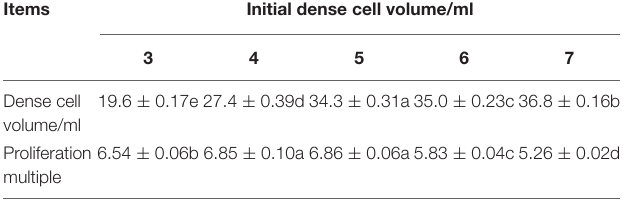
TABLE 1 | Effects of the initial density on the dense cell volume and proliferation multiple of Pinus elliottii × Pinus caribaea embryogenic calli (EC).